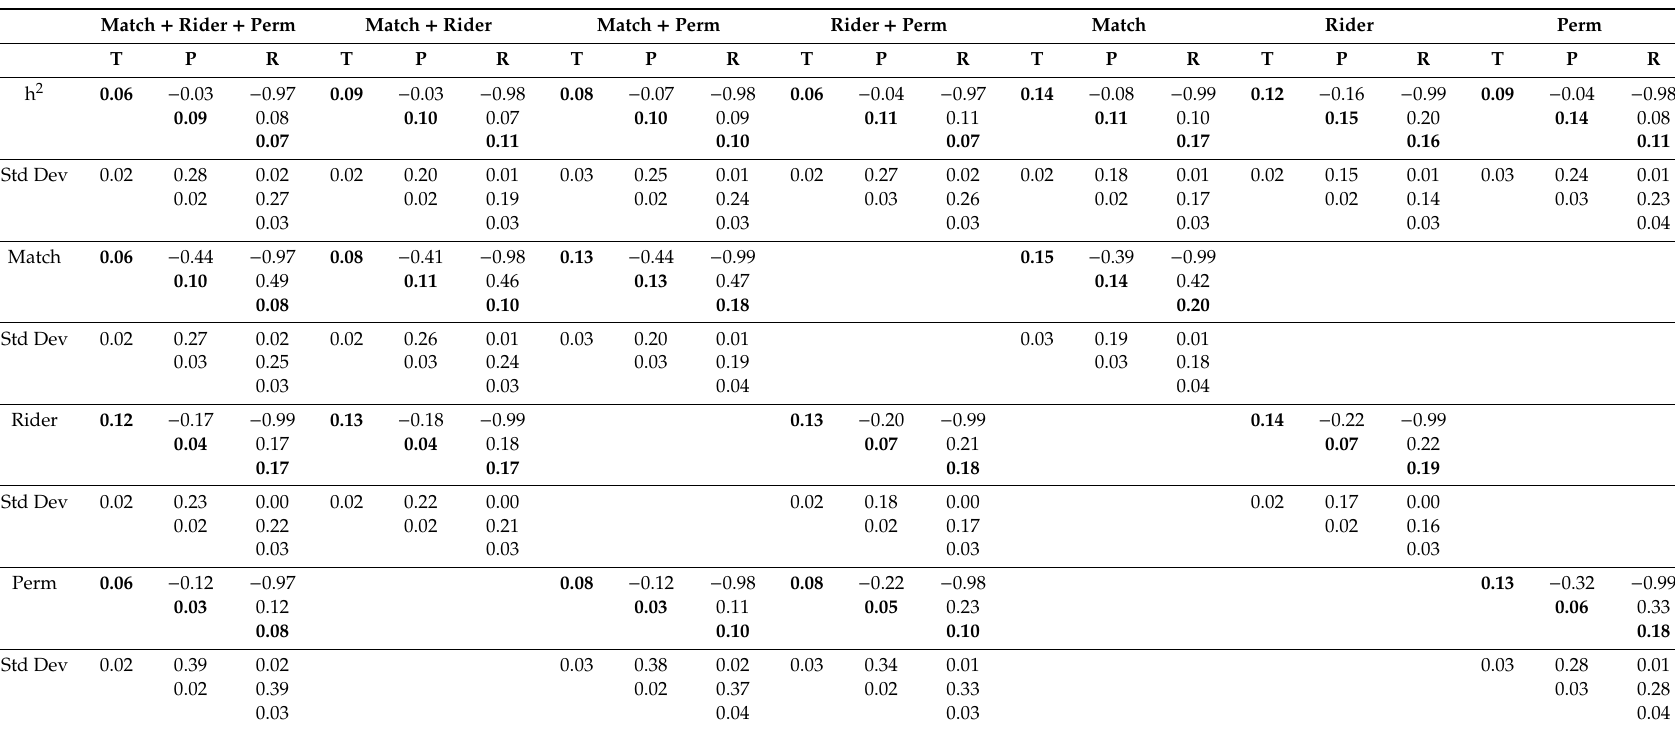
Table 2. Means and standard deviations (Std Dev) of the marginal posterior distributions of heritabilities (h 2 ) and variance over phenotypic ratios of rider, match and permanent (Perm) in diagonals and in bold letters, and correlations between Race Time (T), Placing (P) and Ranking (R) traits for the corresponding e ff ects o ff -diagonals for the whole and the reduced